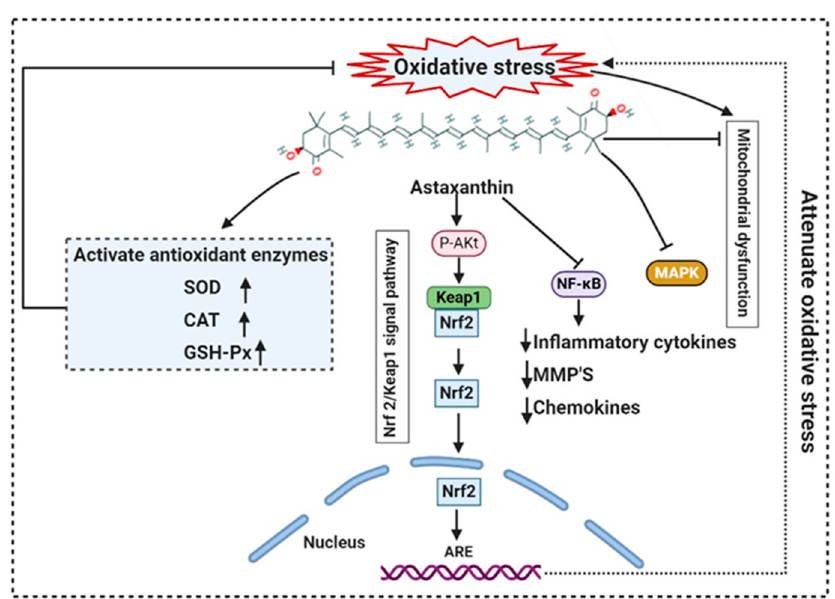
Figure 6. Mode of action of astaxanthin by inhibiting oxidative stress-induced mitochondrial dysfunction and activating transcription factor nuclear factor erythroid 2-related factor 2 (Nrf2). Astaxanthin suppresses nuclear expression of NF- κ B and MAPK to reduce downstream produc- tion of proinflammatory cytokines. NF- κ B: Nuclear factor- κ B; MMP: matrix metallopeptidase; MAPK: mitogen-activated protein kinase; ARE: Antioxidant response elements.